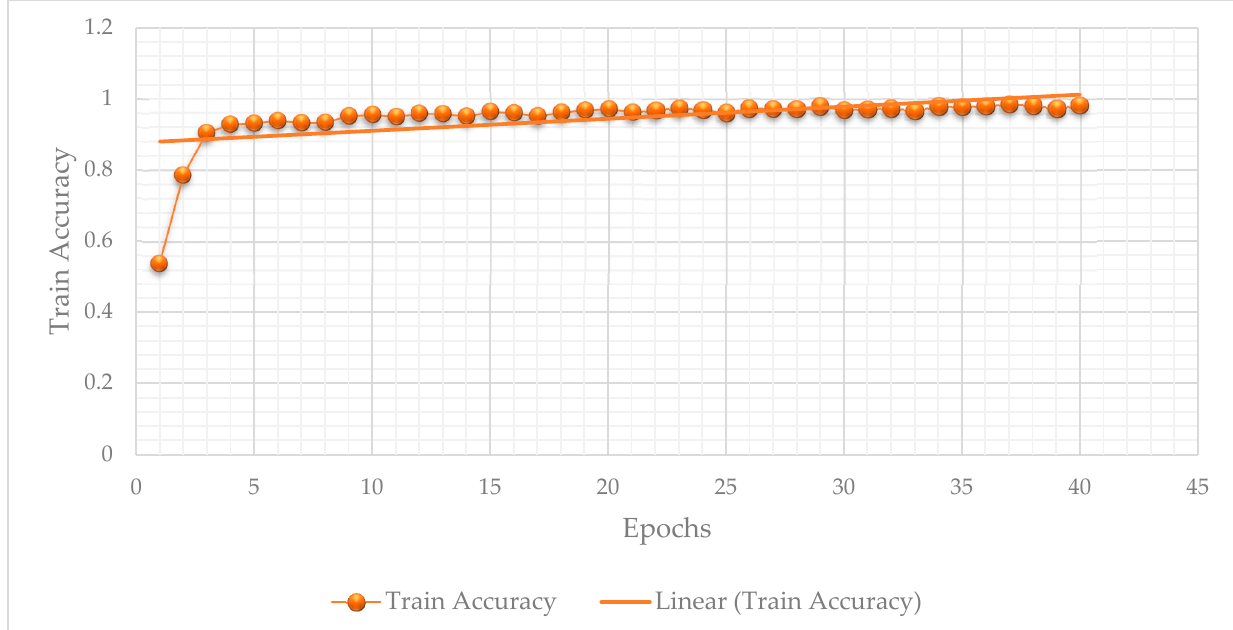
Figure 8. Graph showing train accuracy vs. epoch characteristics.